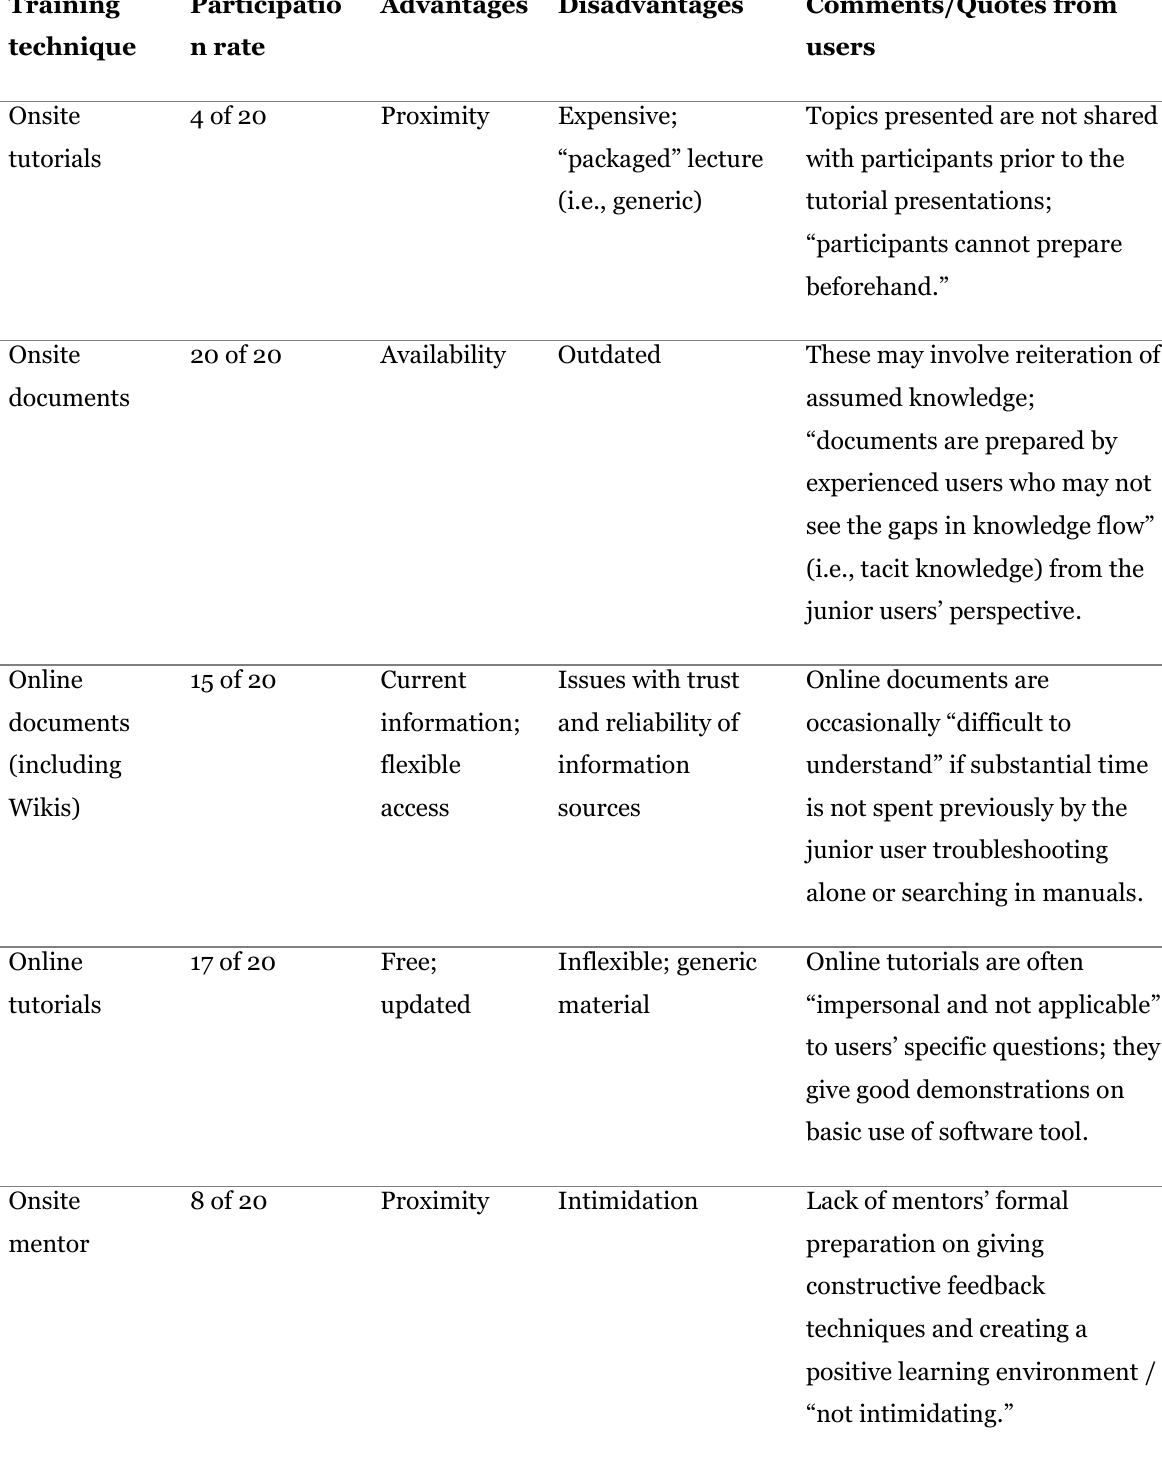
Table 3 Current Training Techniques Followed by Scientific Software